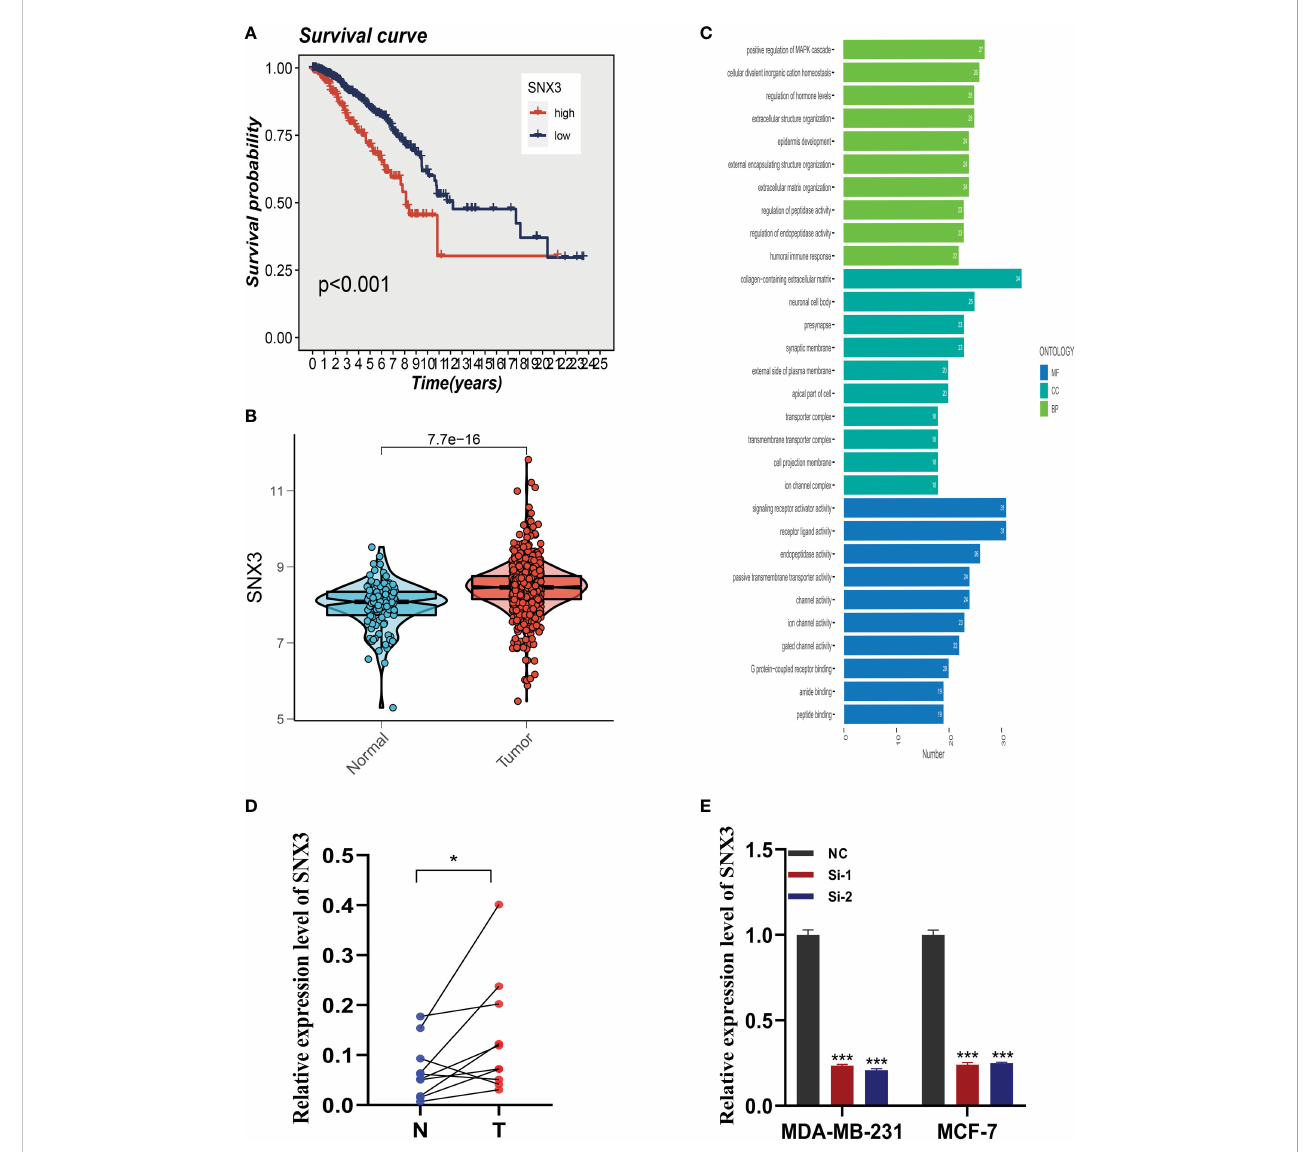
FIGURE 9 Expression analysis and experimental validation of SNX3. (A) Expression of SNX3 in normal and tumor tissues of BC. (B) The overall survival (OS) analysis of SNX3 in the TCGA cohort. (C) GO enrichment analysis of SNX3. (D) PCR assay of clinical samples. SNX3 was highly expressed in BC. (E) SNX3 was knocked down in MCF-7 and MDA-MB-231. (*P<0.05, **P<0.01,